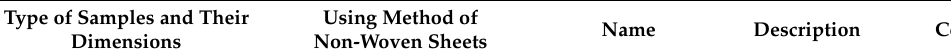
Table 5. Type of samples and exposed tests.